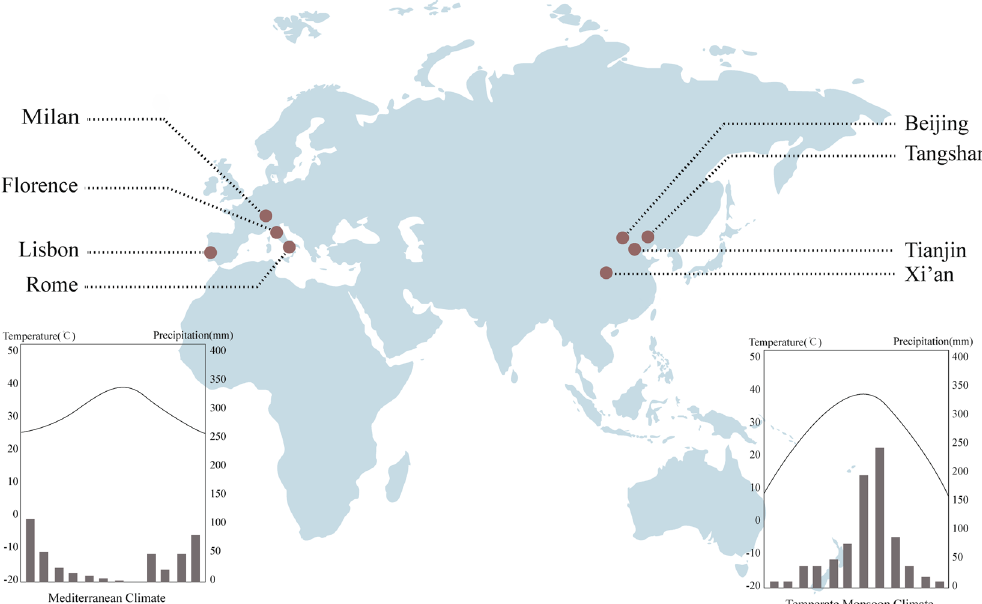
Figure 1. The location of selected study cities and the typical rain-heat relationship between TMC and MC zones. The TMC (Right) is characterized by the rain and heat over the same period, while the MC shows the opposite pattern (Left). Both climate zones have high summer temperatures and experience severe UHI effects. The TMC cities are Beijing, Tianjin, Tangshan, and Xi’an, and the MC cities are Rome, Florence, Milan, and Lisbon. We selected eight cities with similar climatic conditions within the two climate zones (Supplementary Information). The urbanized region within each city and relatively flat areas were chosen to avoid the influence of the